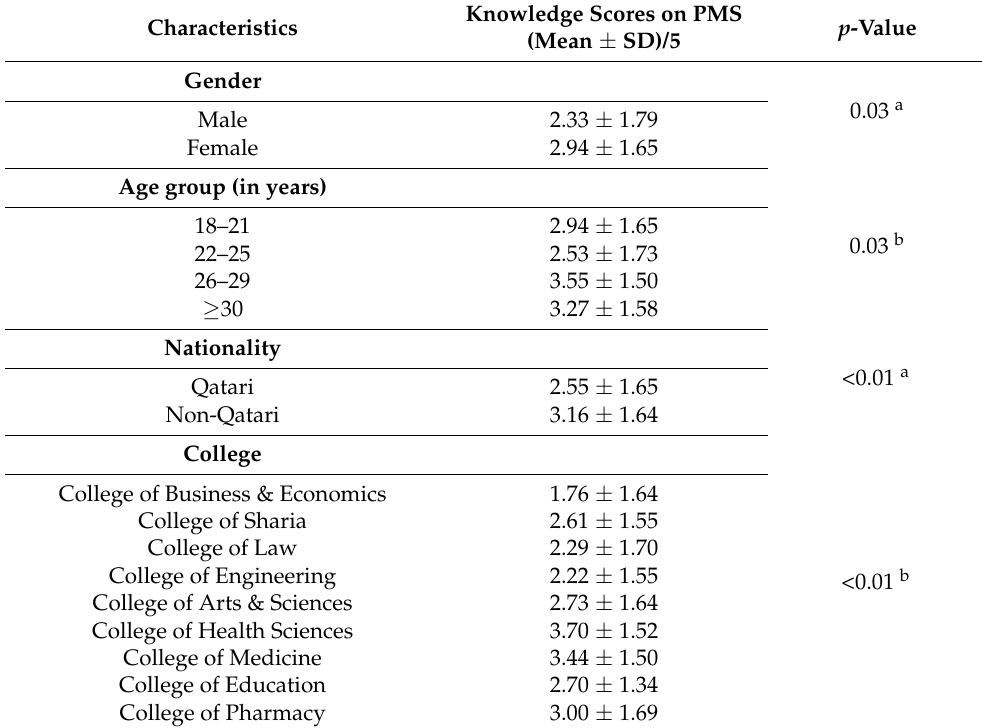
Table 2. Association between knowledge and participants’ characteristics (univariate analysis